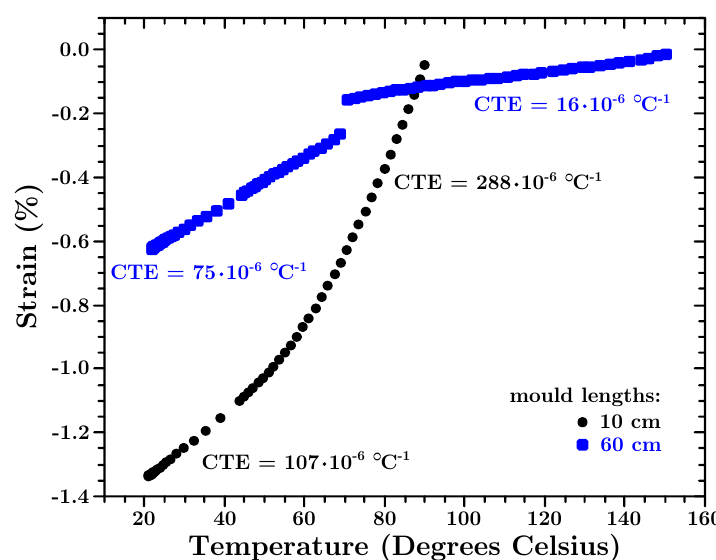
Figure 9. Temperature dependent development of the thermal shrinkage of the middle of the 10cm (black dots) and 60cm (blue squares) samples during Stage VI of the whole curing process. For the epoxy in the middle of the 10 cm mold, the CTE is determined to be 107 · 10 − 6 K − 1